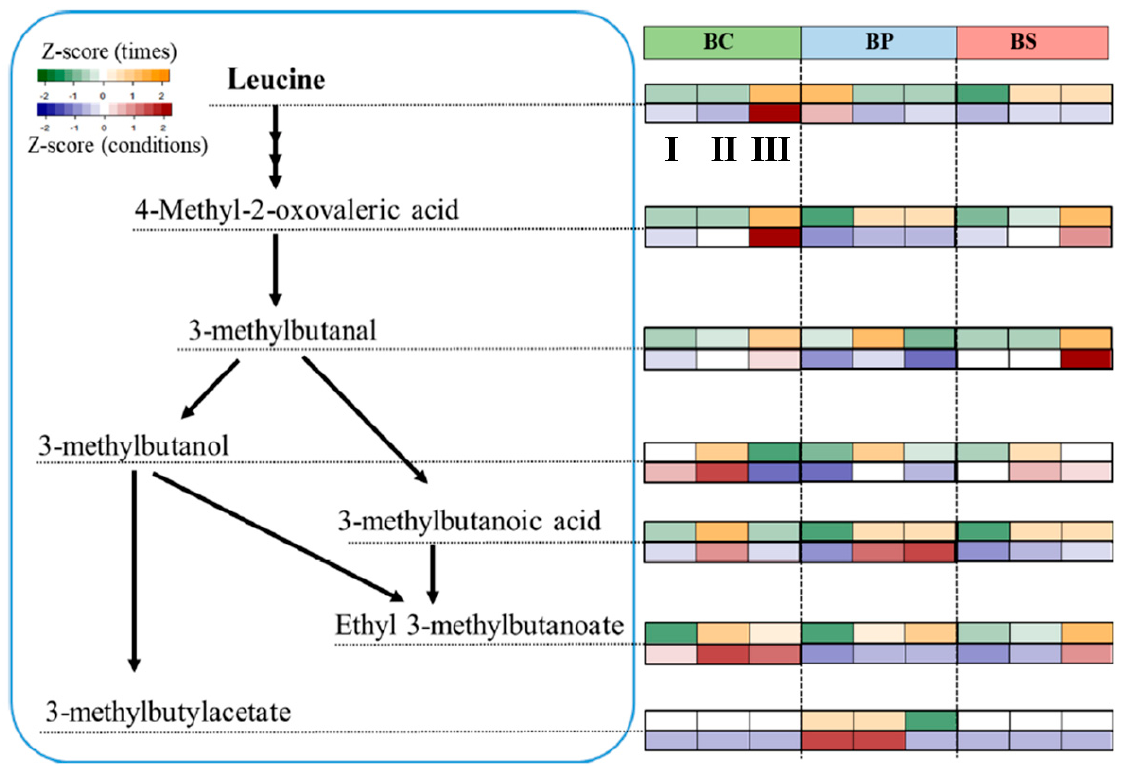
Figure 4. Leucine degradation pathway, reflecting the metabolite changes obtained at phases Ⅰ-Ⅲ in B. subtilis under different cultivation conditions (BC: control; BP: alkaline pH; BS: high salt concentration). The colors (green and orange) represent the changes of metabolites according to culture times in each condition. Blue and red colors represent the metabolic response to culture conditions.